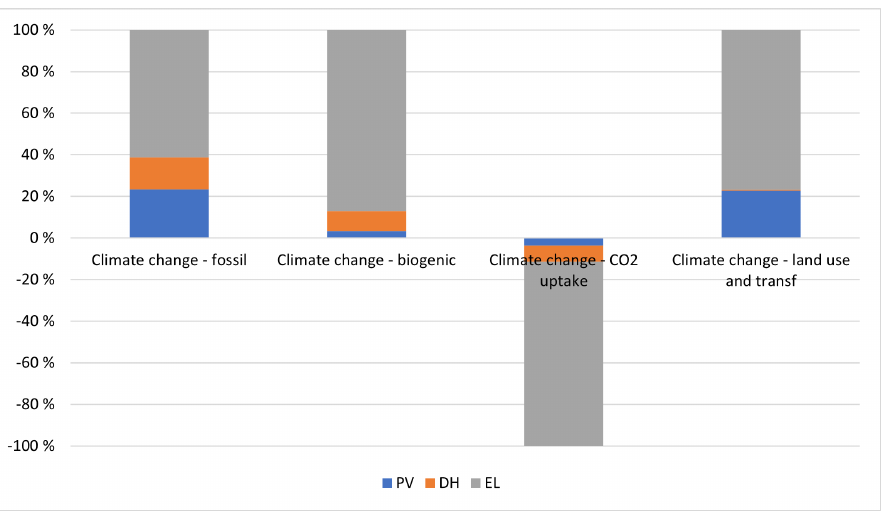
Figure 7. Global warming potential from the Smaragd buildings energy